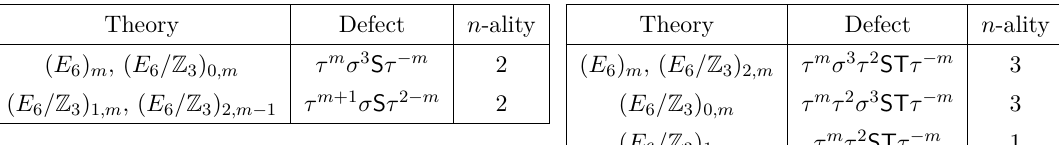
Table 11 . (Non-)invertible symmetries of e 6 at τ YM = i (left) and τ YM = e 2 πi/ 3